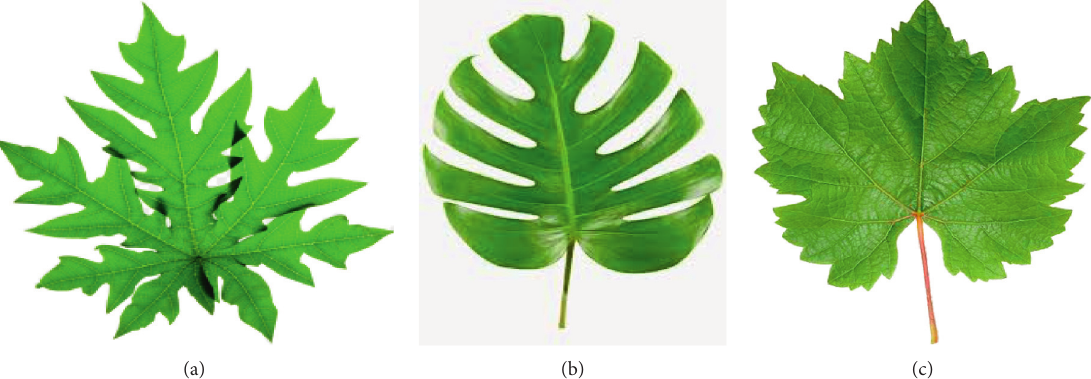
Figure 1: Top-view of the proposed Carica papaya based configurations. (a) Slitless patch, (b) Defected-width ground plane, (c) L-slitted patch antenna.